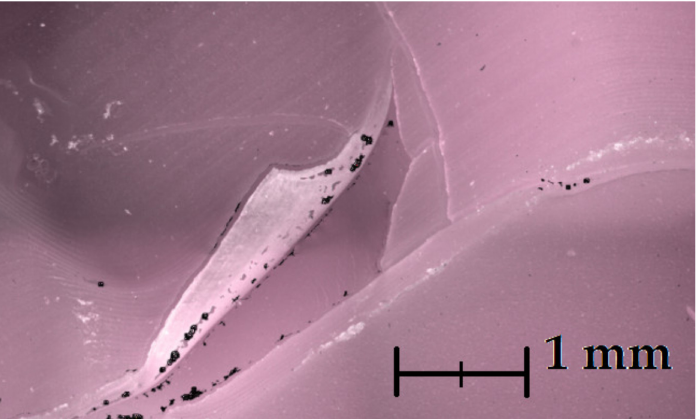
Figure 6. Image of a flaking site on the cylindrical section of the parts’ geometry created during the measurement with a focus variation microscope. A red hue is a side effect of using a polarized light source. Black spots are non-measured